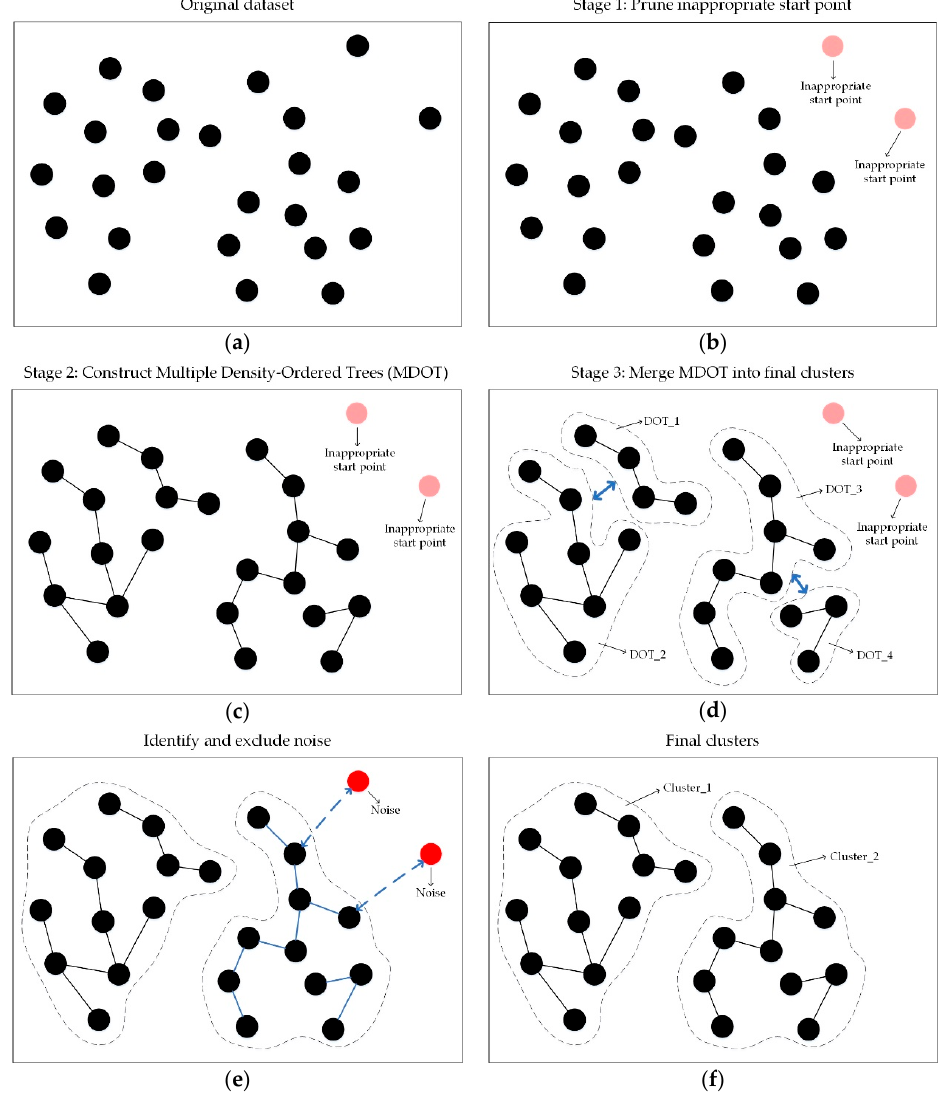
Figure 2. The process of Spatial Clustering with Multiple Density-Ordered Trees (SCMDOT) consists of three main stages including the pruning stage, the constructing stage and the merging stage. ( a ) Original dataset; ( b ) Prune inappropriate start point; ( c ) Construct Multiple Density-Ordered Trees (MDOT); ( d ) Merge MDOT into final clusters; ( e ) Identify and exclude noise; ( f ) Final clusters.